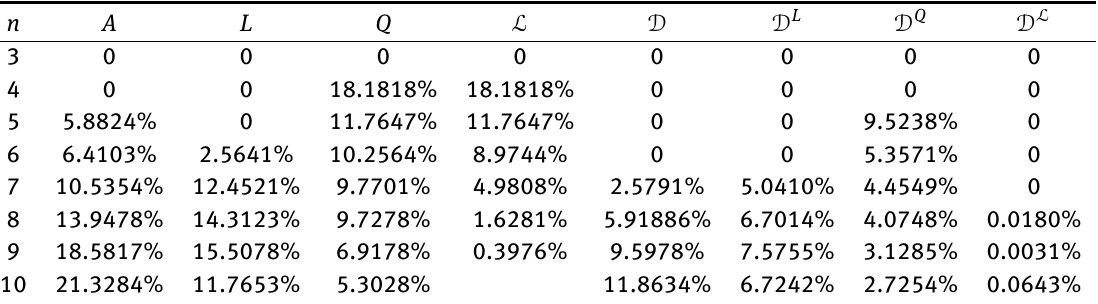
Table 5: Percent of total graphs (for A , L , Q , L ) / connected graphs (for D , D L , D Q , D L ) that have a cospectral mate with re- spect to each